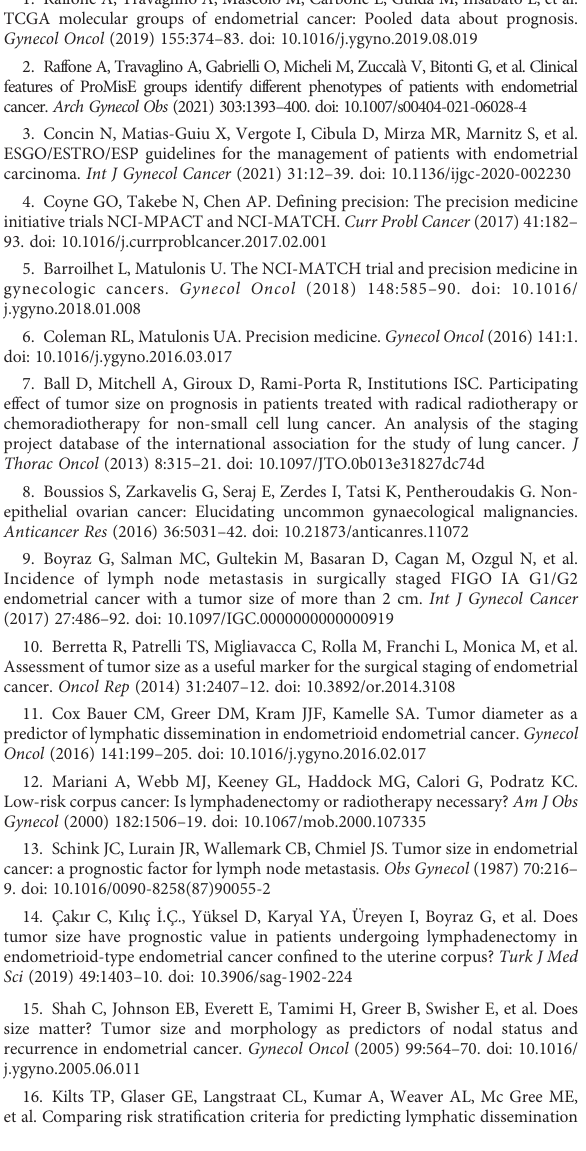
SUPPLEMENTARY FIGURE 5 Kaplan – Meier survival estimates of time to death from cancer, for prognostic group (age, BMI, stage, grade, LVSI, myometrial invasion, lymph node involvement, histotype, adjuvant treatment) and by SUPPLEMENTARY FIGURE 8